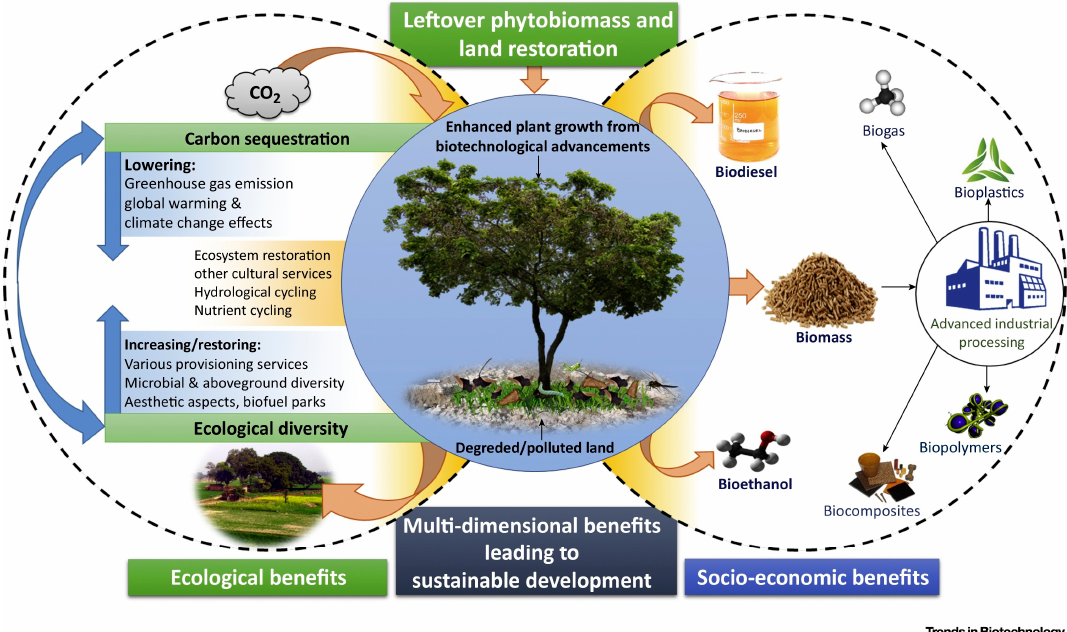
Figure 3. Schematic representation of coupling bioremediation with bioenergy and other value-added products generation for supporting a bio-based economy [14].